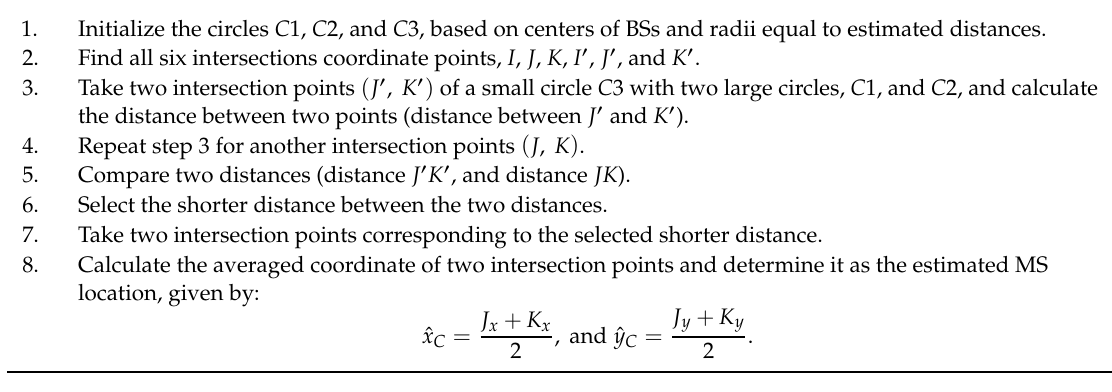
Figure 4. Concept of the comparison approach of intersection distances in the specific case.